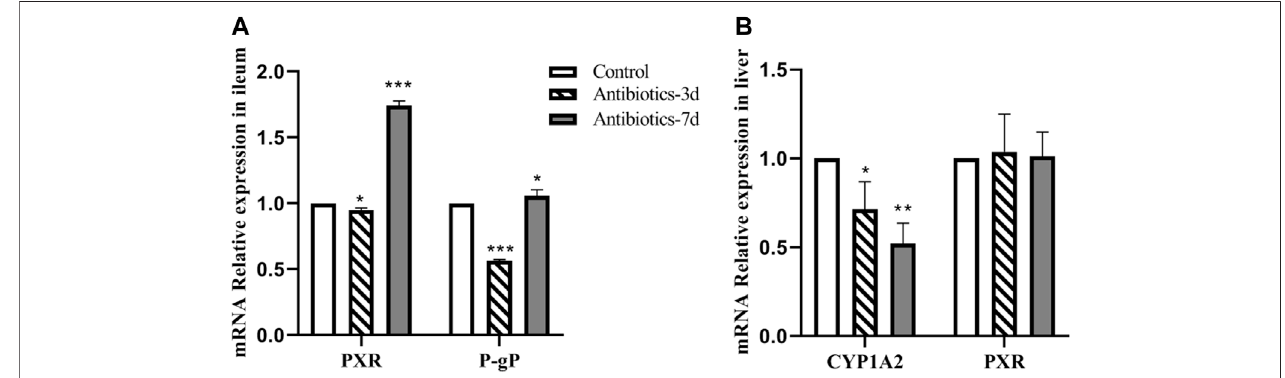
FIGURE 6 | Effect of an intestinal fl ora imbalance on liver drug enzymes and P-gp mRNA expression in the terminal ileum. Antibiotics were used to intervene the intestinal fl ora of rats for 3 and 7 days, respectively. RT-PCR was used to detect the level of mRNA expression of PXR and P-gp (A) in the ileum, and CYP1A2 and PXR (B) in the liver. *** p < 0.0001; ** p < 0.005; * p < 0.05. The intervention groups were compared with the control